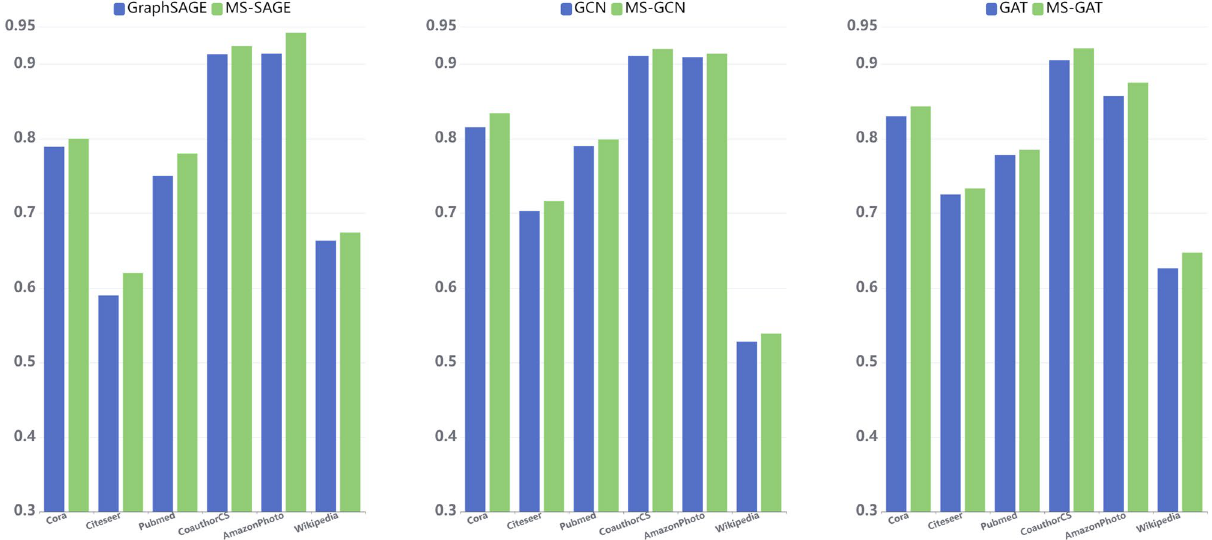
Figure 7. The accuracy of GCN and MS-GCN, GraphSAGE and MS-SAGE, GAT and MS-GAT were compared in